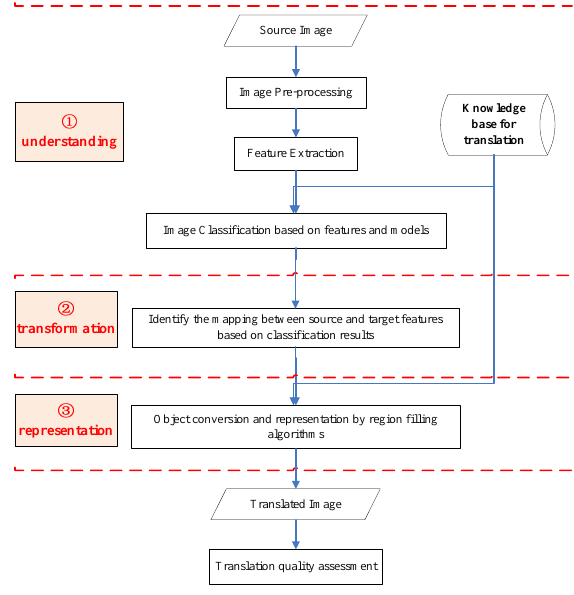
Figure 2. The general flow of image translation Dictionary is an important tool for language translation, which provides rhyme, explanation, sample, usage, etc. Dictionaries, rule databases and the division of the marked corpus are also helpful to machine translation systems. In remote sensing image translation, grey and texture features, classification models, translation rules, and sample images are usually